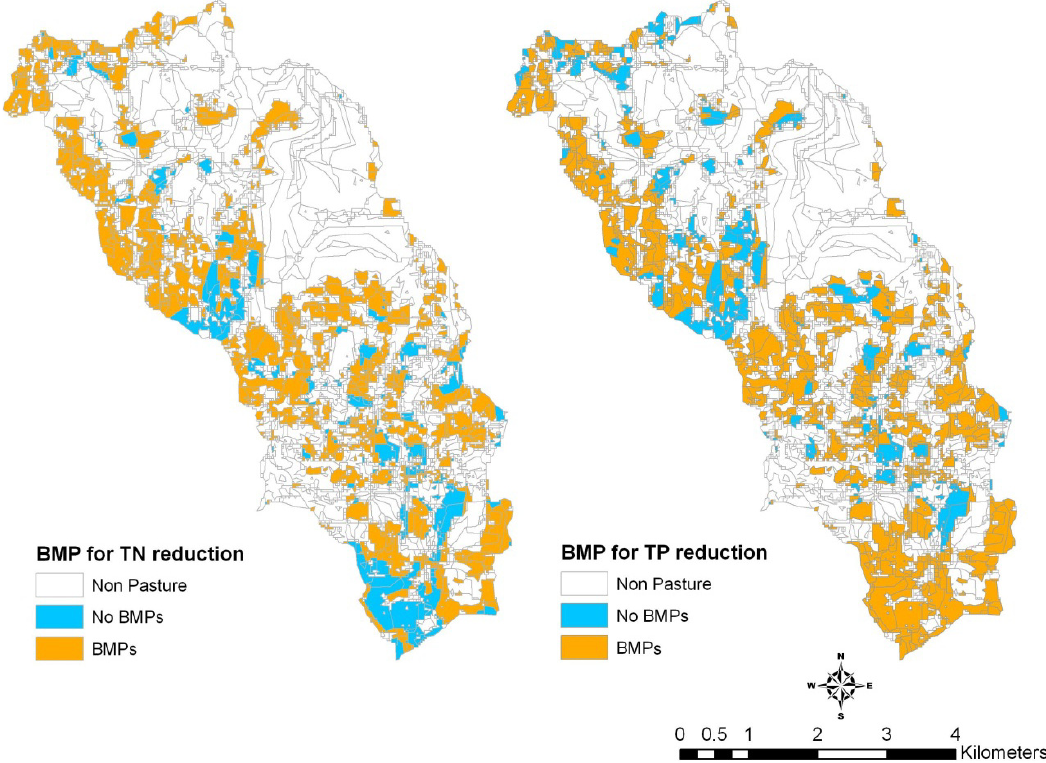
Figure 8. Distribution of BMPs selected by the targeting method on 77% of the pasture lands in the